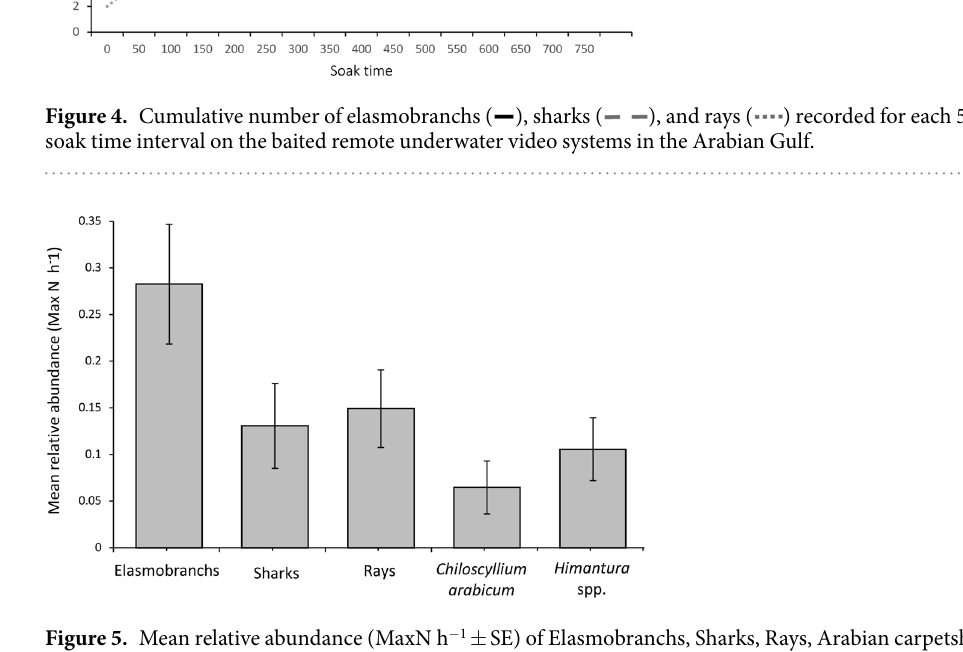
Figure 5. Mean relative abundance (MaxN h − 1 ± SE) of Elasmobranchs, Sharks, Rays, Arabian carpetshark Chiloscyllium arabicum , and stingrays Himantura spp. determined by baited underwater video